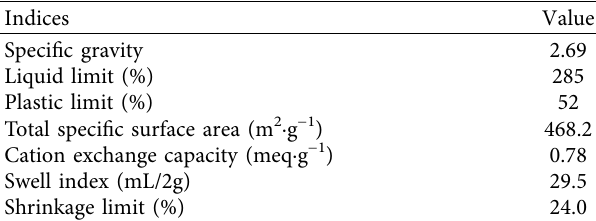
Table 1: Basic properties of Gaomiaozi bentonite.